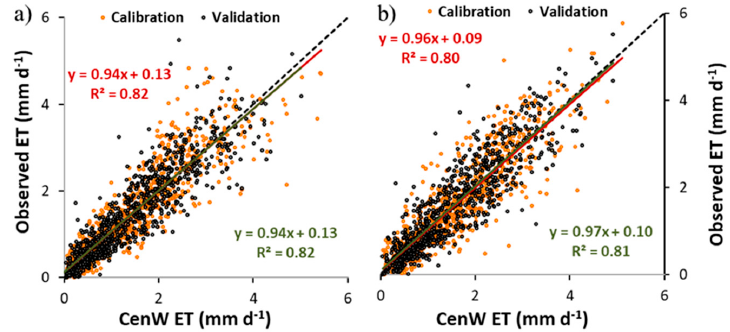
Figure 5. Scatter plots of observed vs. modeled evapotranspiration rates for the mown ( a ) and grazed ( b ) paddocks. ( b )